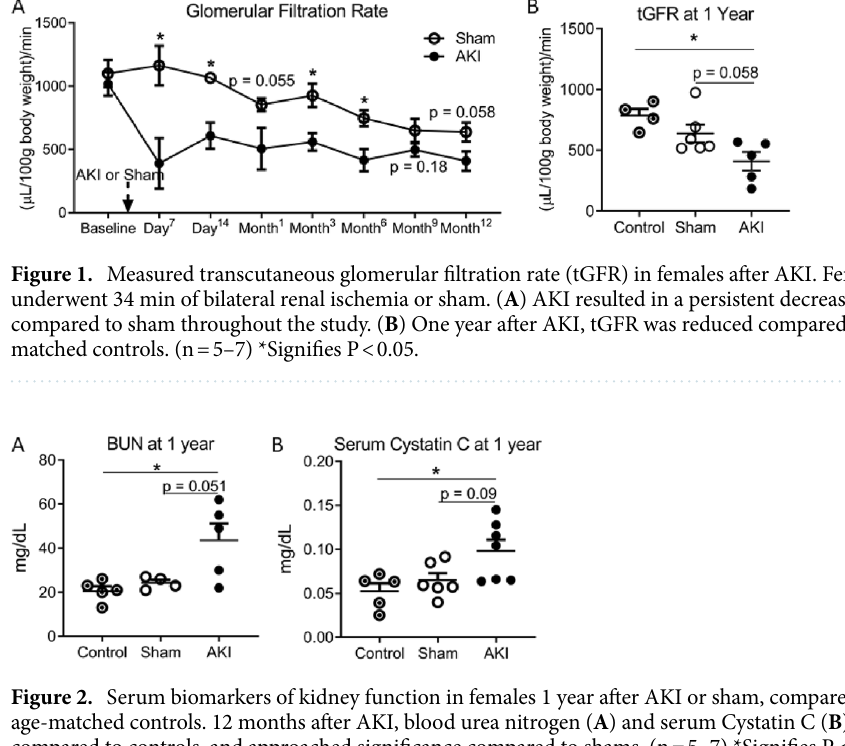
males 21 , one year after AKI, female cardiac ATP was preserved compared to sham (Fig. 5). Kidney ATP was